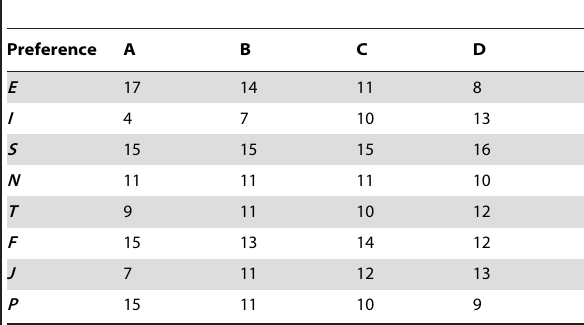
Table 2. The average score of preference for each of the one hundred subjects